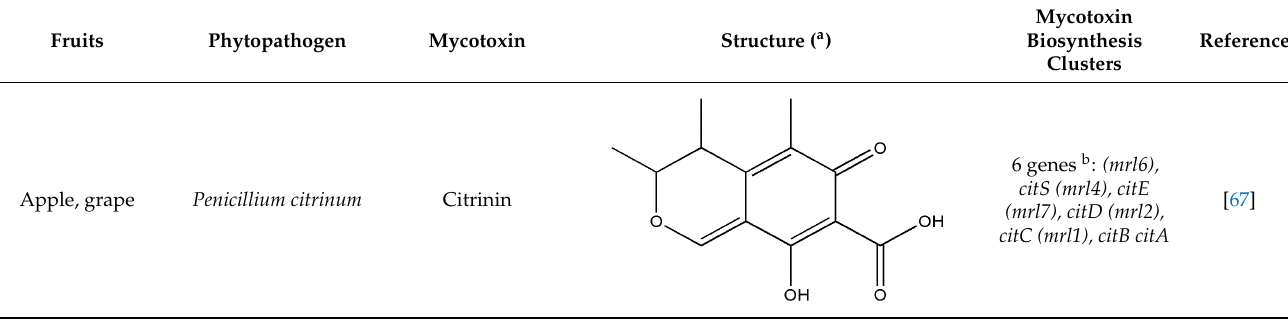
Table 2. Mycotoxins produced by various fungi during fruit-fungal infection.